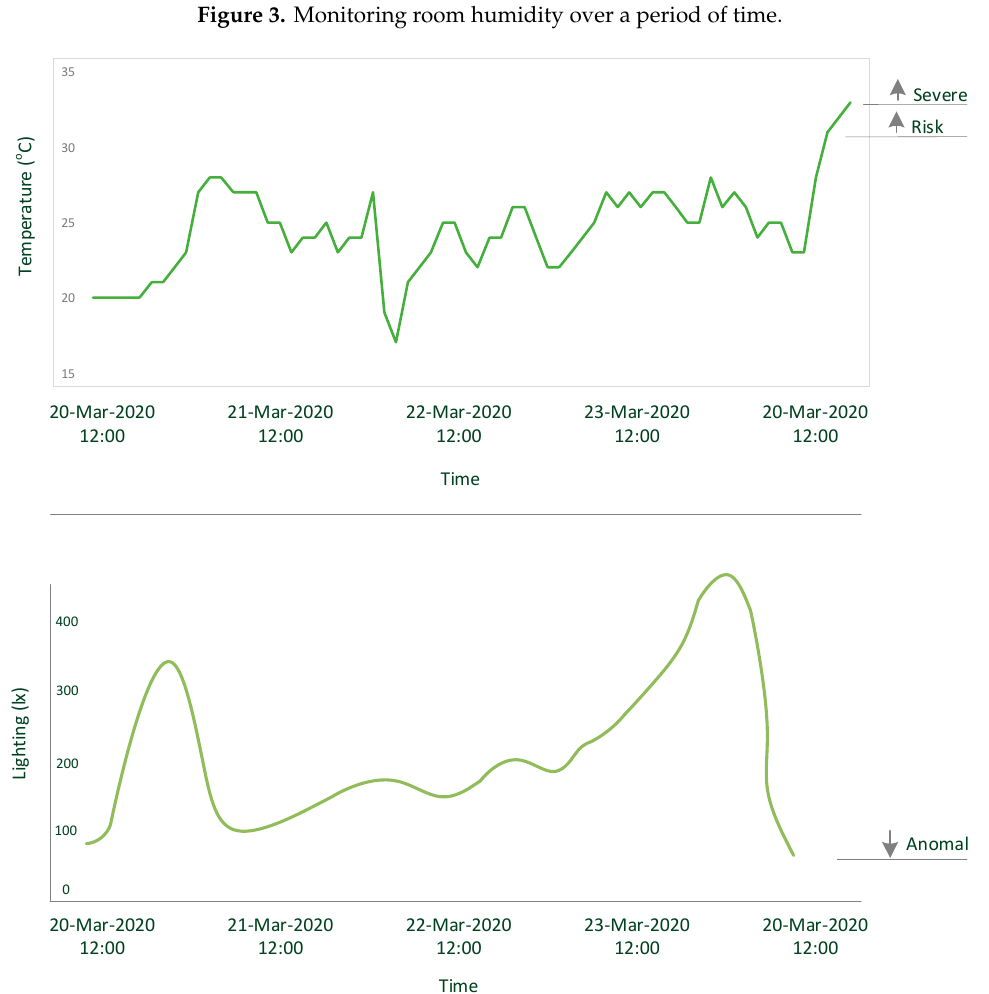
Figure 4. Controlling room lighting and temperature.